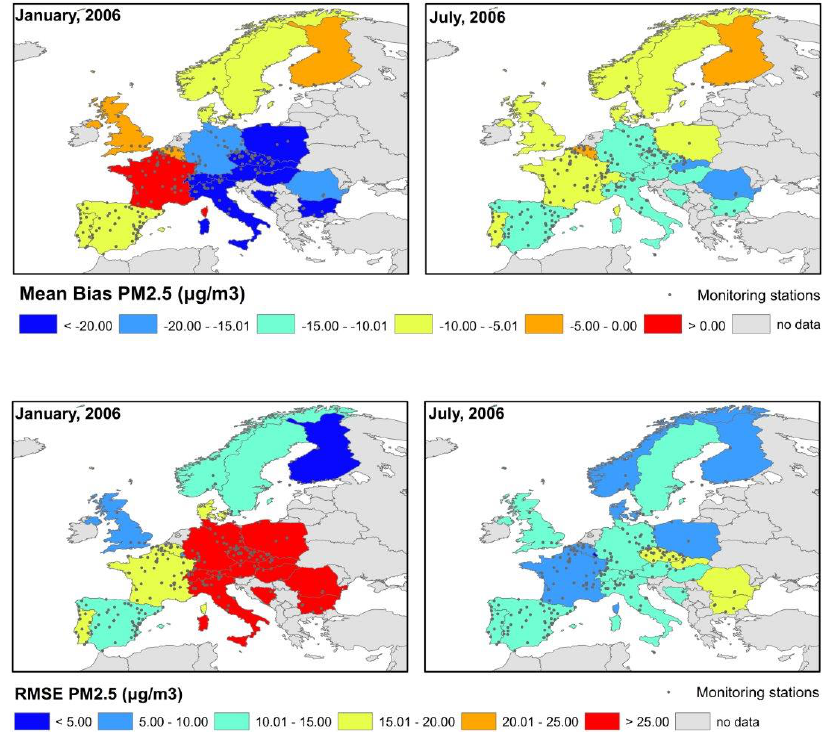
Fig. 7. Mean Bias and RMSE for daily average PM 2 . 5 concentrations for the European countries (dots show the distribution of PM 2 . 5 monitoring